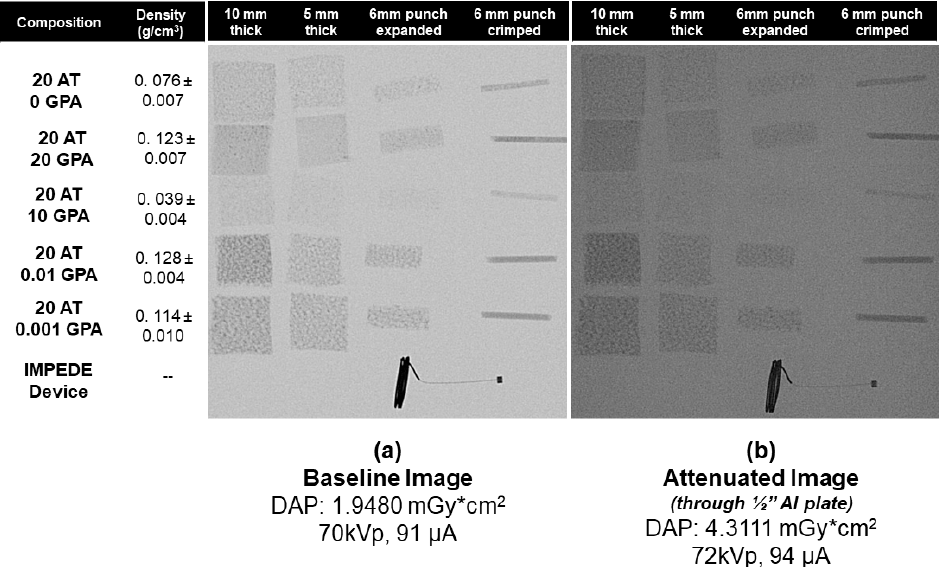
Figure 6. Selected SMP foams with 20 mol% ATIPA and varying amounts of GPA imaged on OrthoScan C-arm. The left image ( a ) was imaged directly to serve as a baseline image. The right image ( b ) was performed through a 1 / 2 ” Al plate to simulate the attenuated image when imaging through bone. Foam samples in columns are labeled with thickness for cubes and crimp state of 6 mm diameter cylindrical biopsy punch samples.